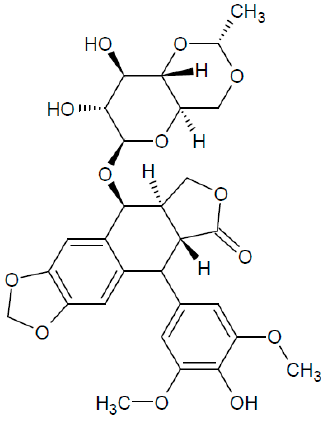
Figure 6. Etoposide structure.